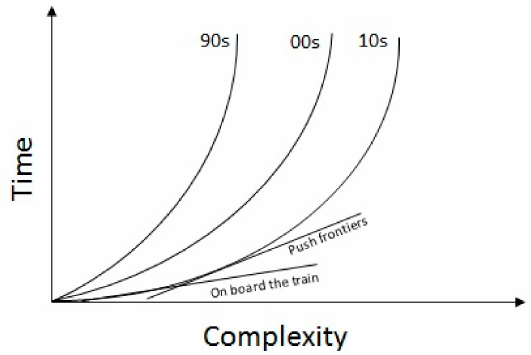
Figure 5. Qualitative assessment of required time for M&S. The numbers represent the